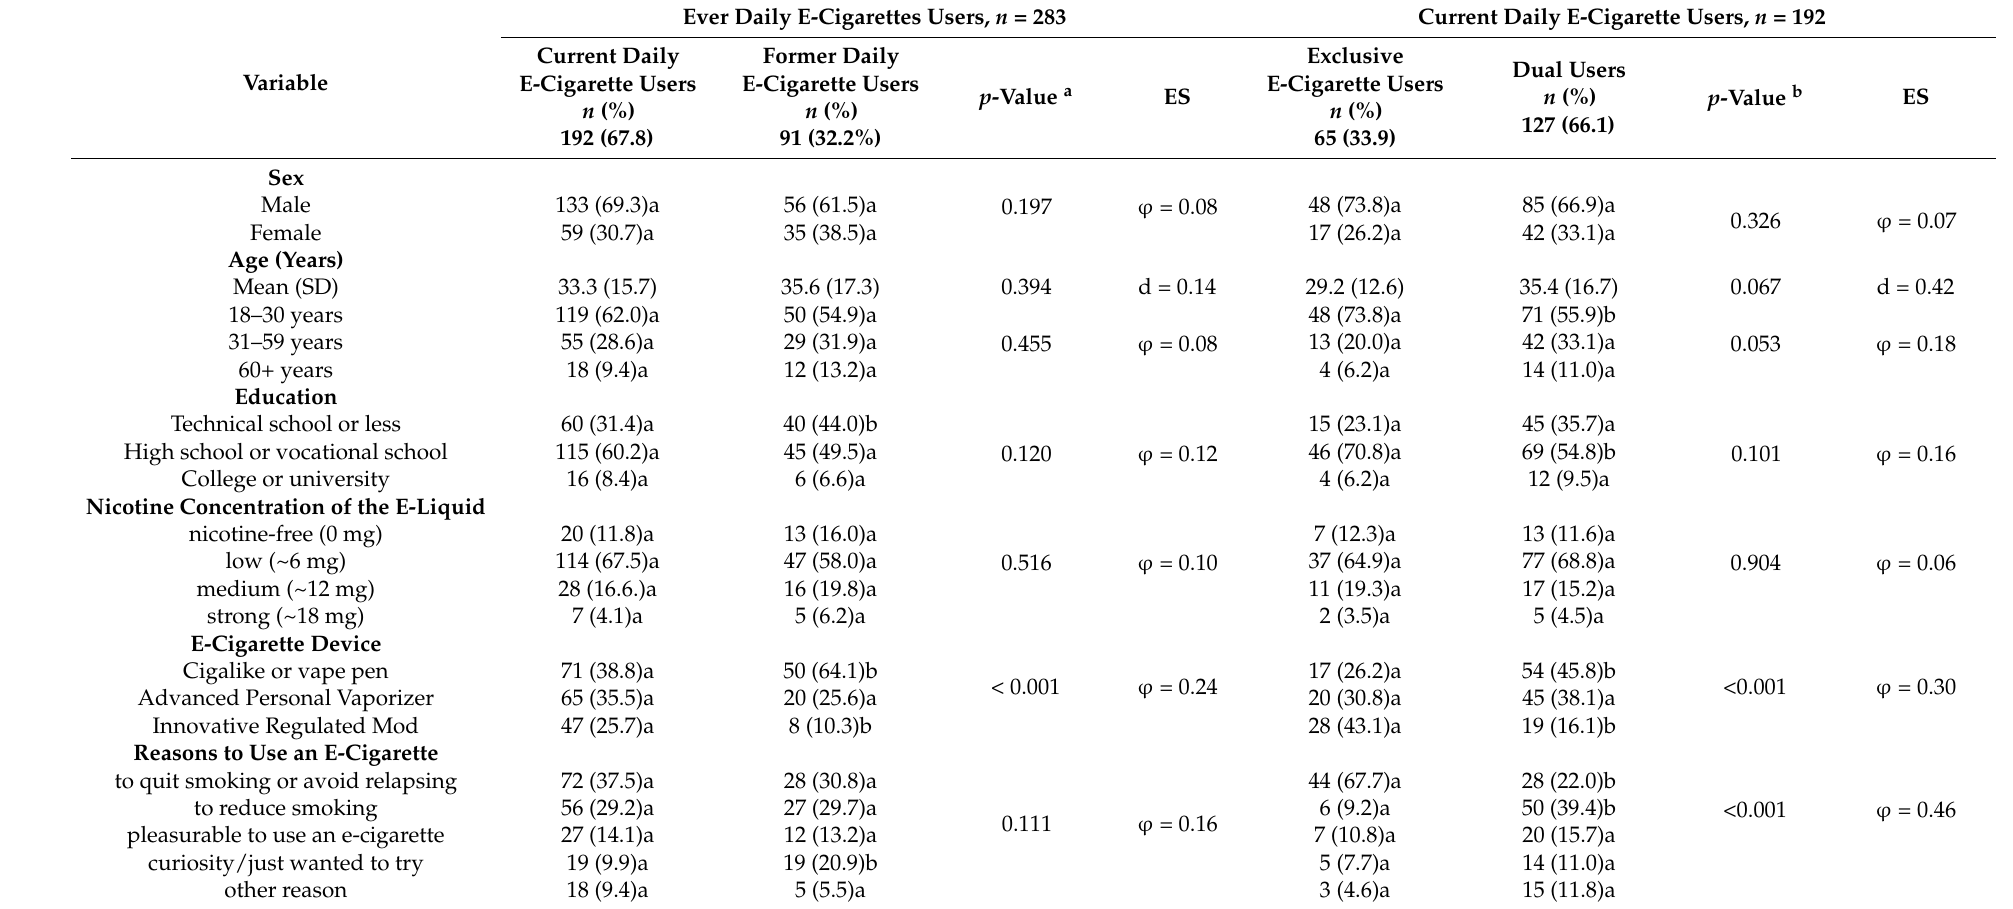
Table 1. Descriptive characteristics of current daily and former daily e-cigarette